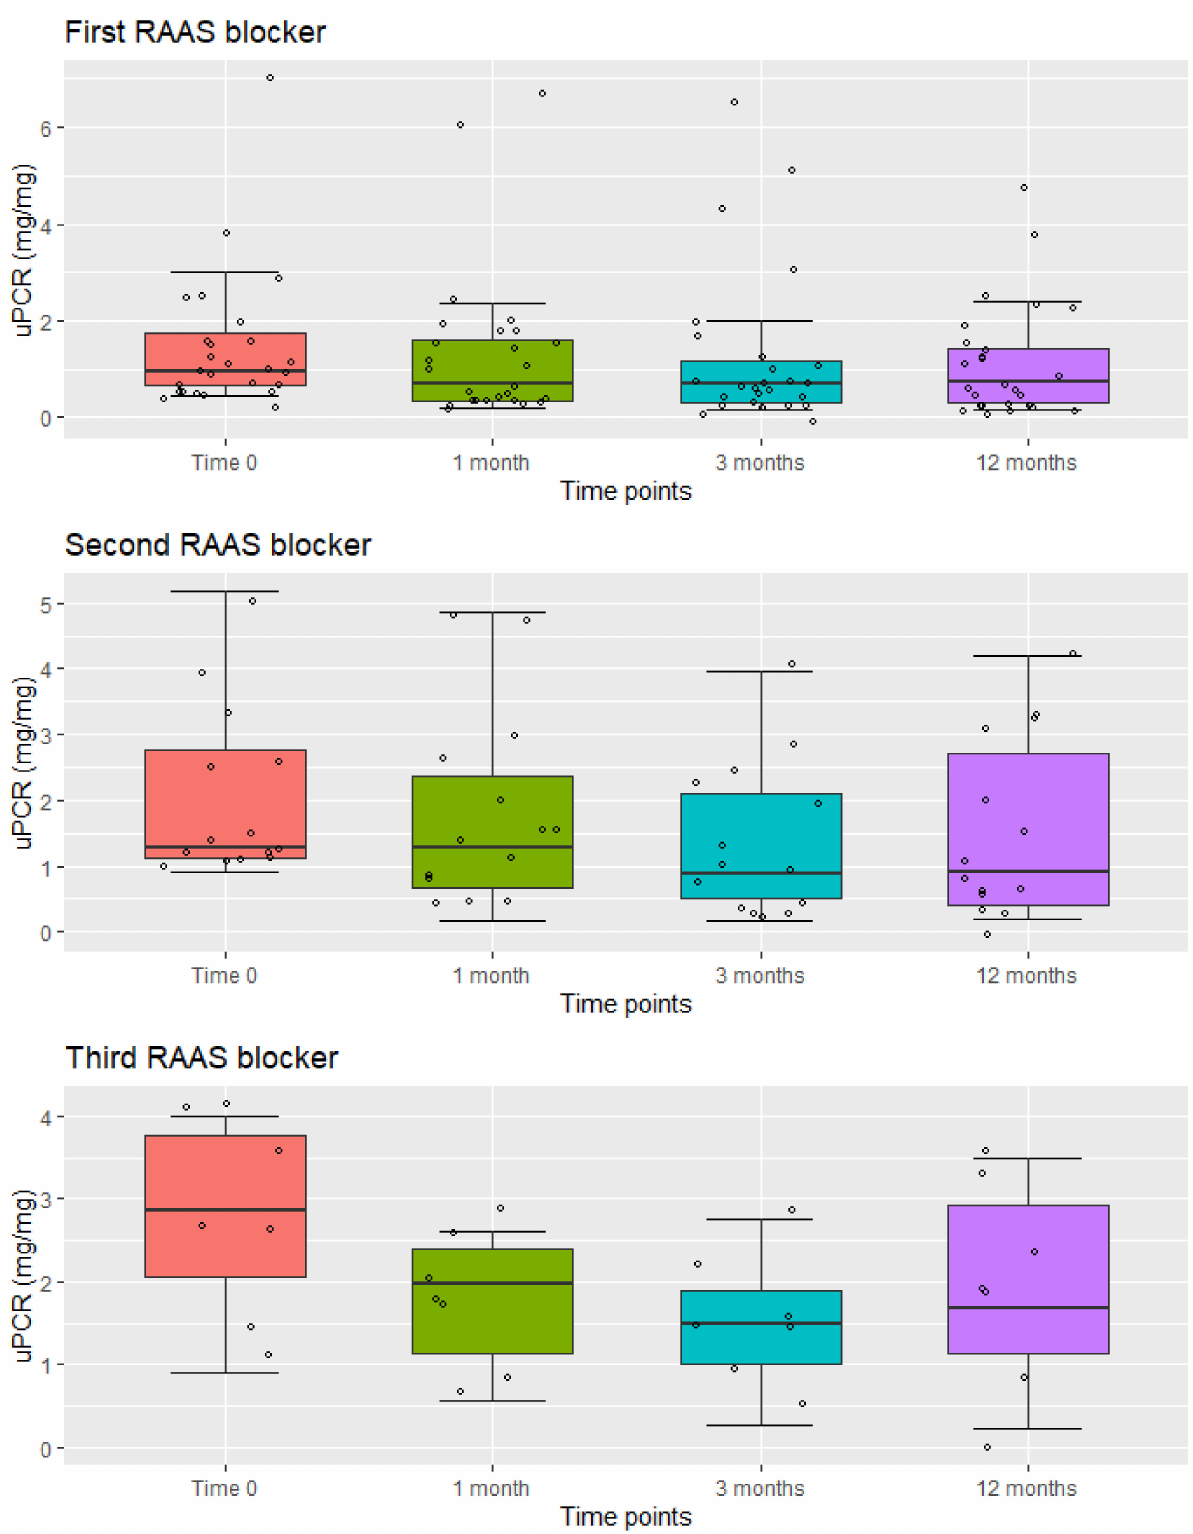
Figure 2. Boxplots of the distribution of uPCR values at different time points from the introduction of the first, second, and third RAAS blocker. The measured values are represented by